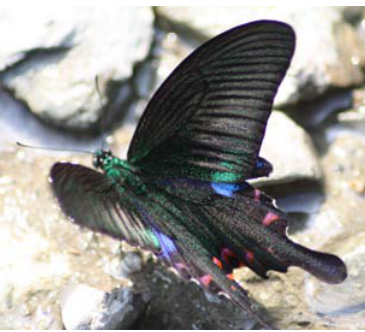
Image 21. Papilio protenor euprotenor